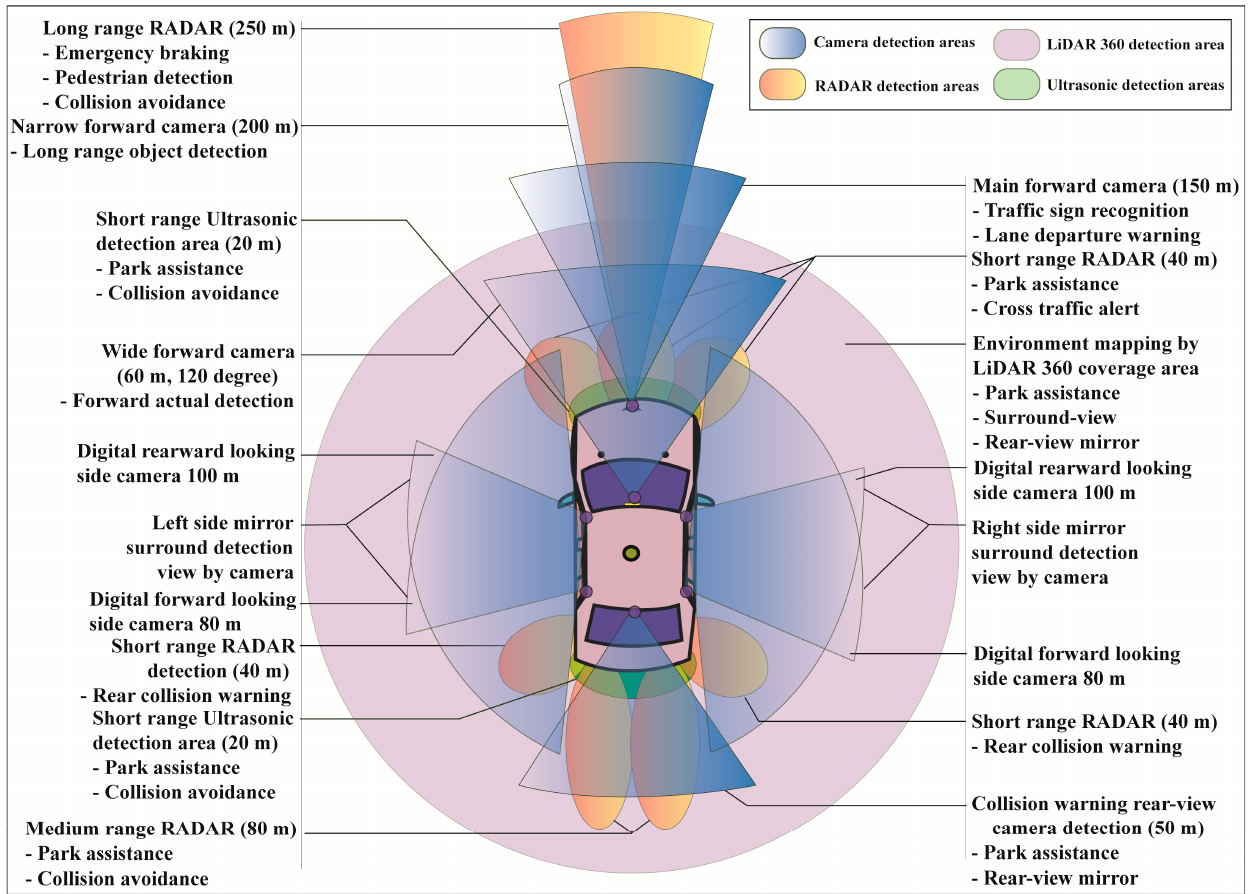
Figure 3. Surround sensing of an autonomous vehicle with di ff erent types of cameras, RADARs, LiDAR, and ultrasonic sensors. LiDAR, and ultrasonic